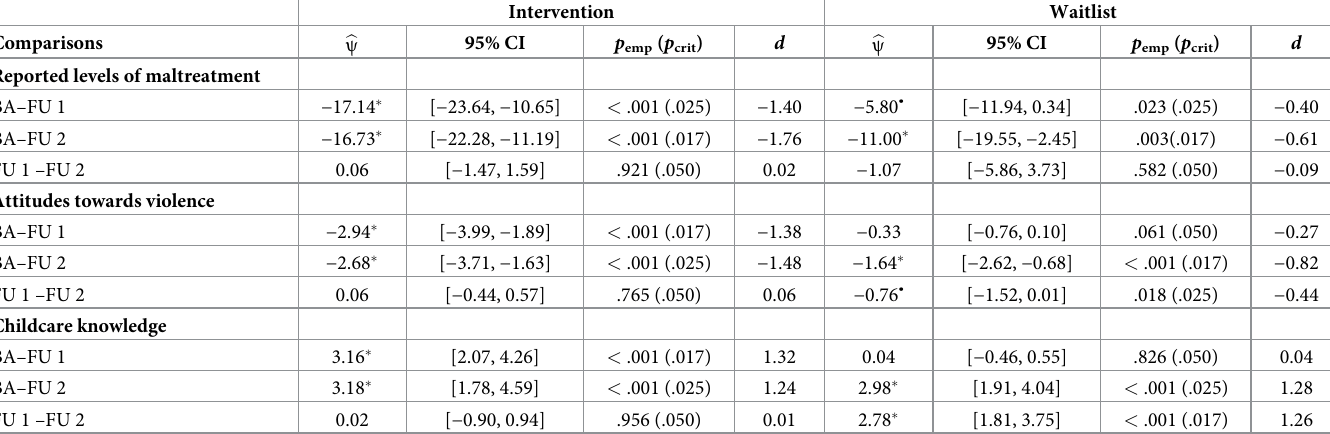
Table 3. Pairwise comparisons of the training effect in the primary outcomes separated by intervention and waitlist